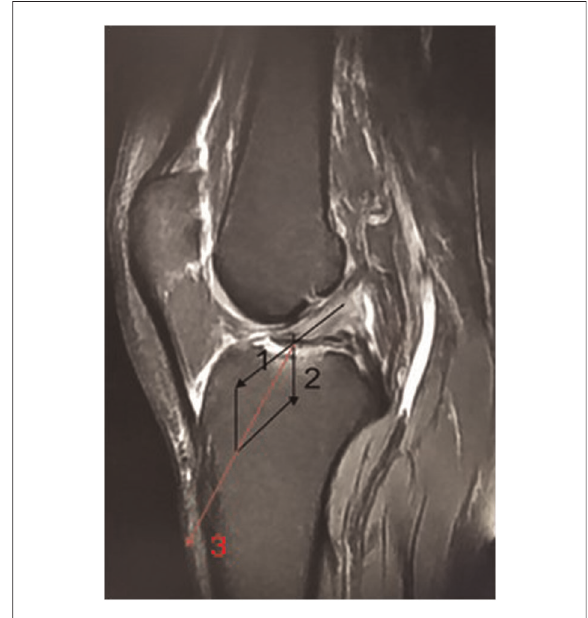
FIGURE 10 (1) The direction of the force line represents the tension direction of the anterior bifurcate ligament. (2) The direction of the force line represents the pressure direction of the fracture block. (3) The direction of the button where was fi xed at the combind force direction, which was between the bone mass and the